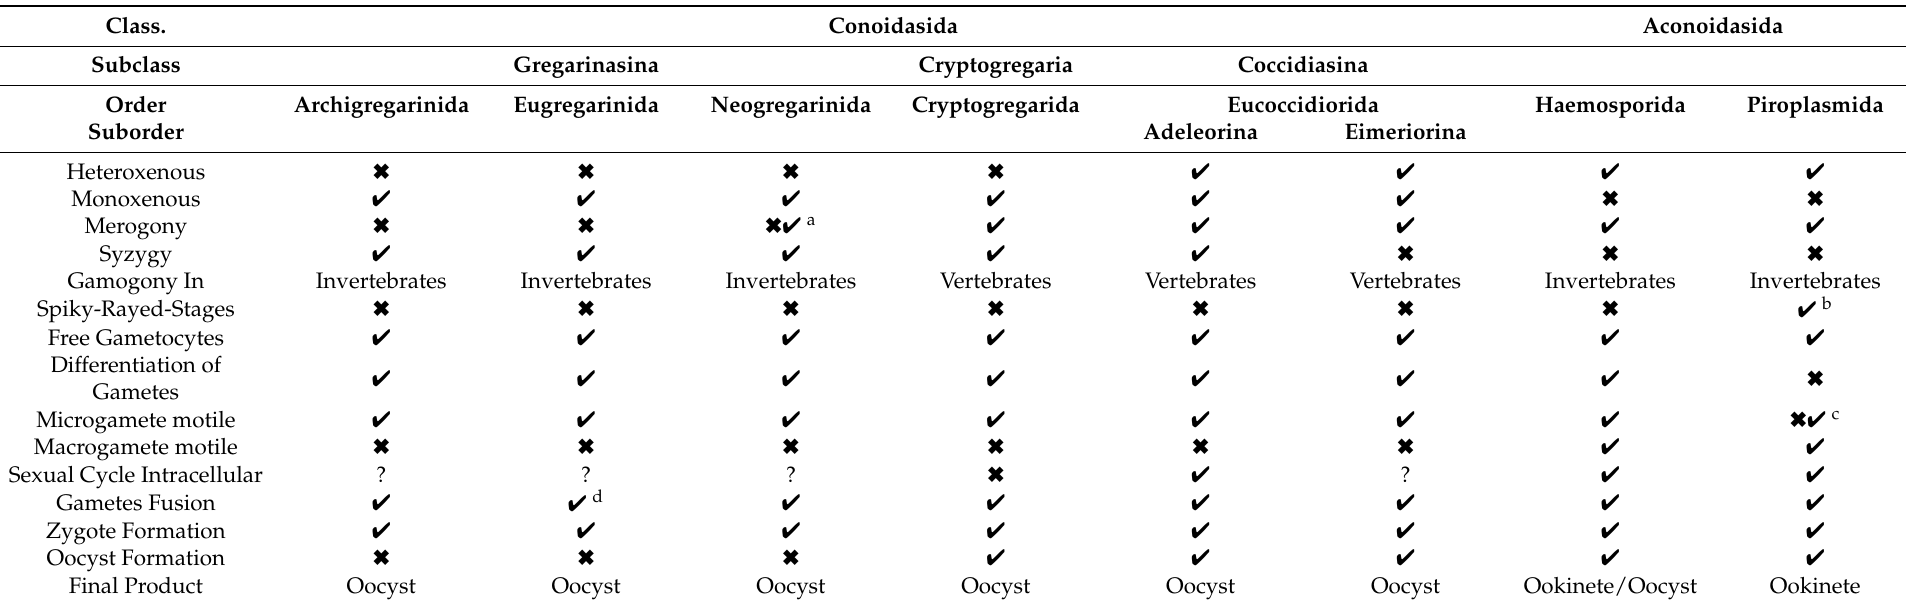
Table 1. Overview of characteristic life cycle events of Conoidasida and Aconoidasida. (cid:52) , present; (cid:54) , absent; ?, uncertain. Apicomplexan life cycles can vary greatly between taxa and species; however, shared characteristics are described here. a , the absence of merogony is dependent on the species; b , the two gamete populations are indistinguishable by light microscopy; c , the mobility of the gametes is dependent on the species; d , in Eugregarinorida this process is called “gamete-dance”, as both gametes move in circles around each other. The table is composed based on the references provided in the text.